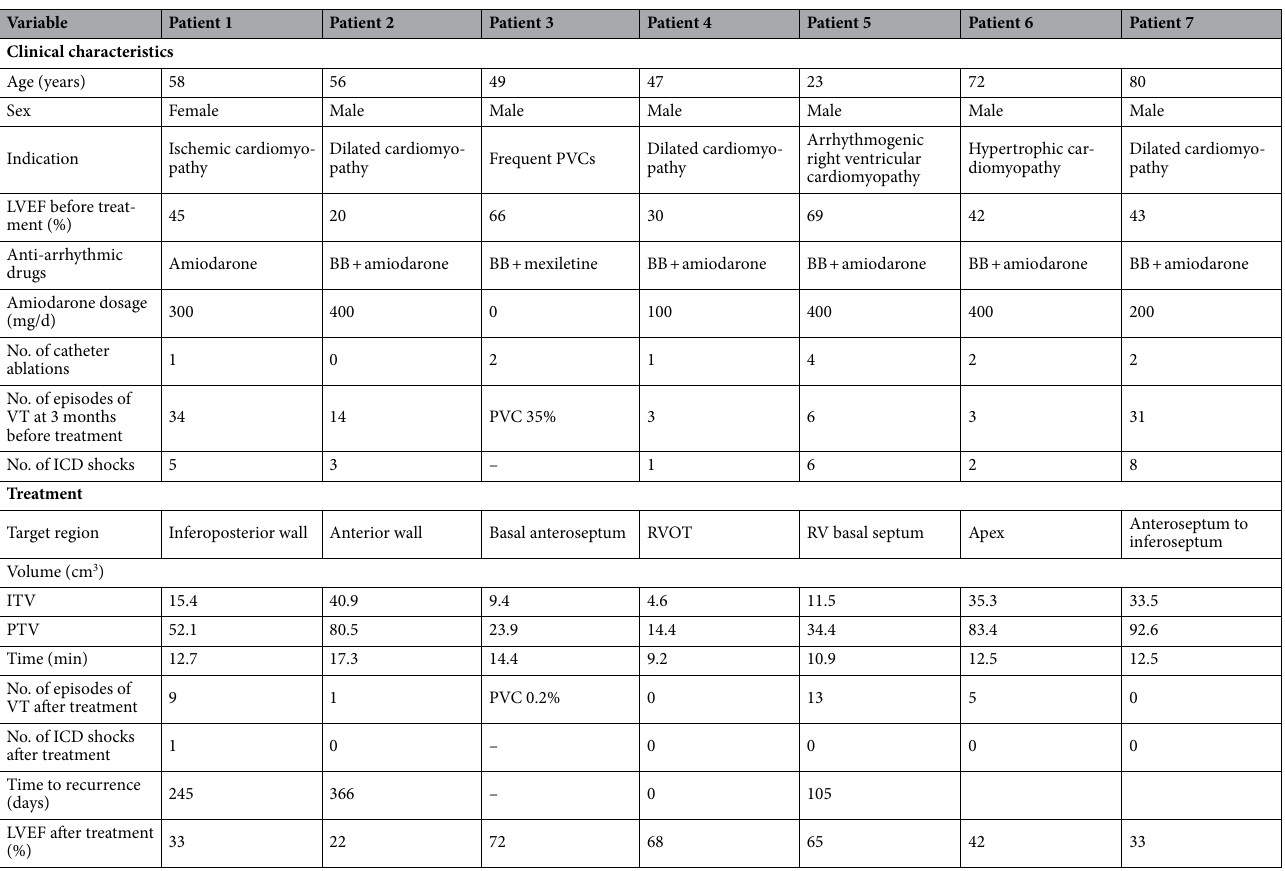
Table 1. Patients’ clinical characteristics and treatment details. PVC premature ventricular contraction, BB beta-blocker, LVEF left ventricular ejection fraction, VT ventricular tachycardia, ICD implantable